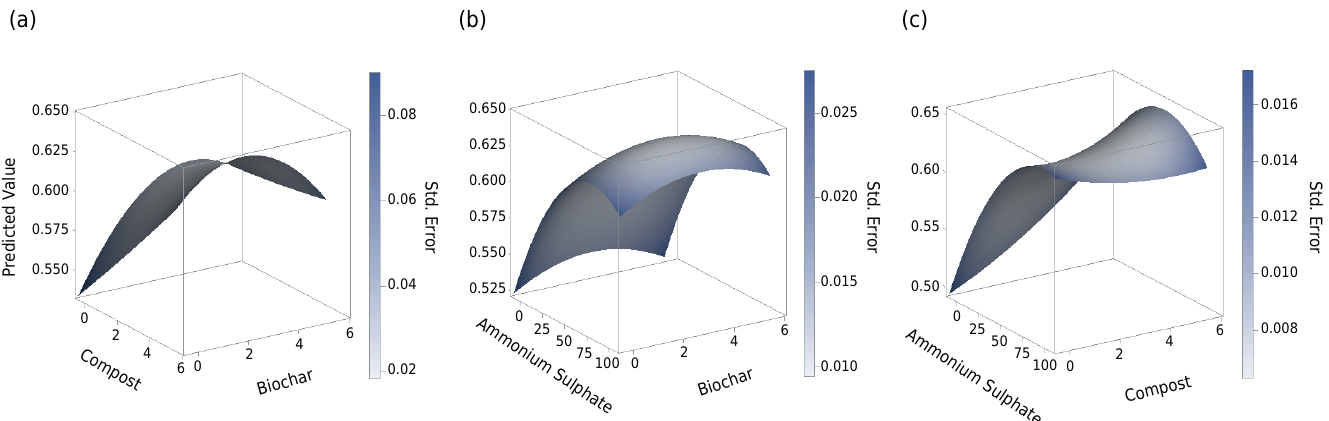
Figure 3. The TC (kg kg -1 of chlorophyll in leaf) response to independent variable: (a) biochar (t ha -1 ) and compost (t ha -1 ); (b) biochar (t ha -1 ) and ammonium sulphate (kg ha -1 ); (c) compost (t ha -1 ) and ammonium sulphate (kg ha -1